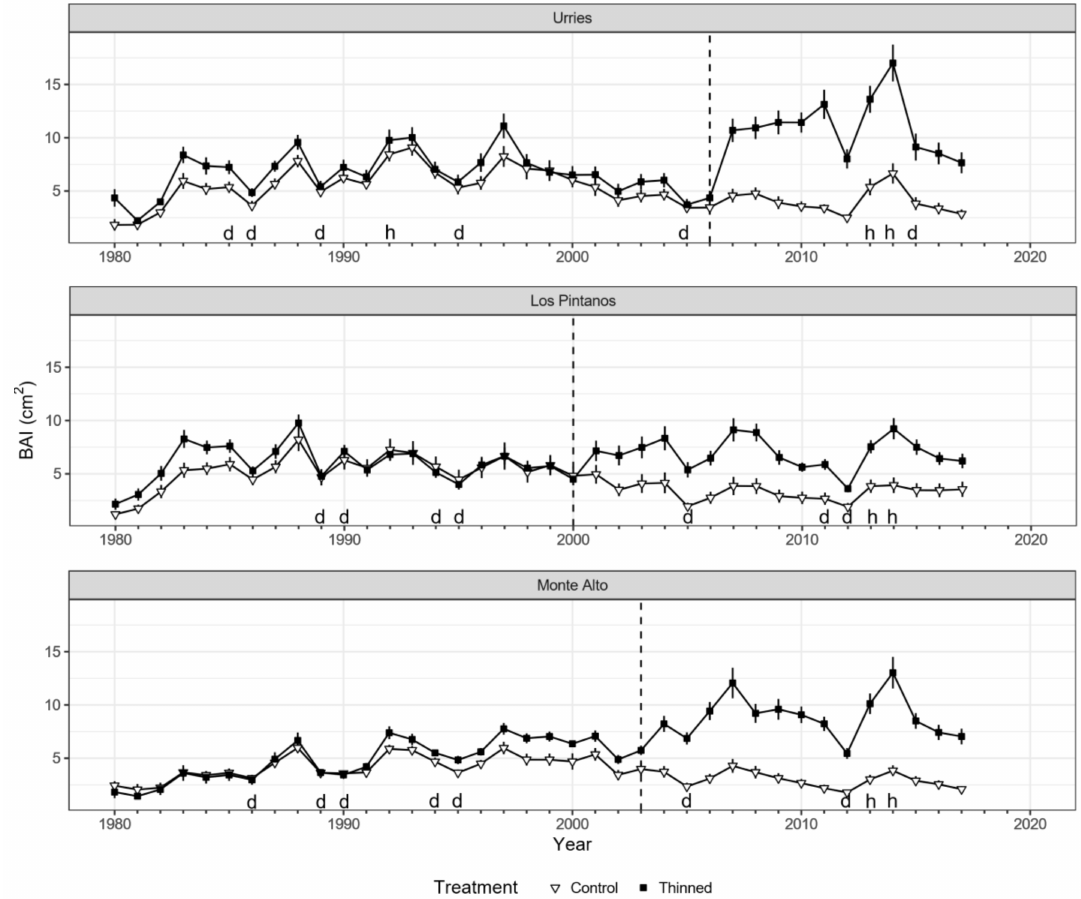
Figure 2. Basal area increment (BAI) series of Pinus nigra in Urri é s, Los Pintanos, and Monte Alto for control plots (black squares) and thinned plots (white triangles). Points represent mean values, while vertical bars depict standard errors. The dashed vertical lines represent thinning treatments (2006, 2000, and 2003 in Urri é s, Los Pintanos, and Monte Alto). Letters h and d above the x-axis indicate humid (SPEI > 1.28) and dry (SPEI < − 1.28) years,